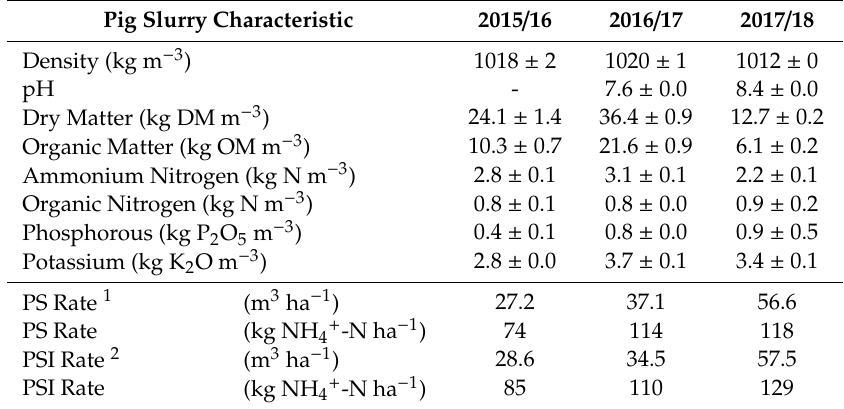
Table 3. Physicochemical characteristics of slurry from fattening pigs (mean ± standard error; n = 3) and rates of pig slurry and nitrogen applied each